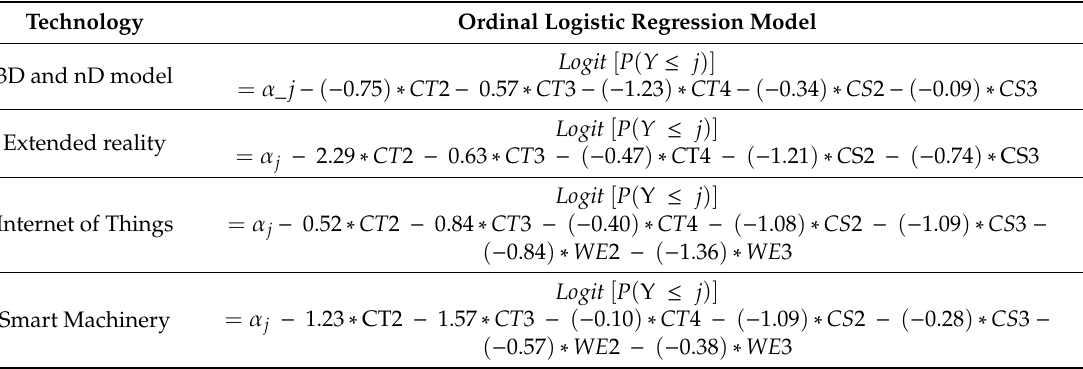
Table 5. Ordinal logistic regression model for China.